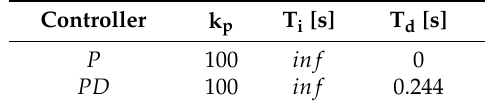
Table 1. The nominal settings of P and PD controllers.